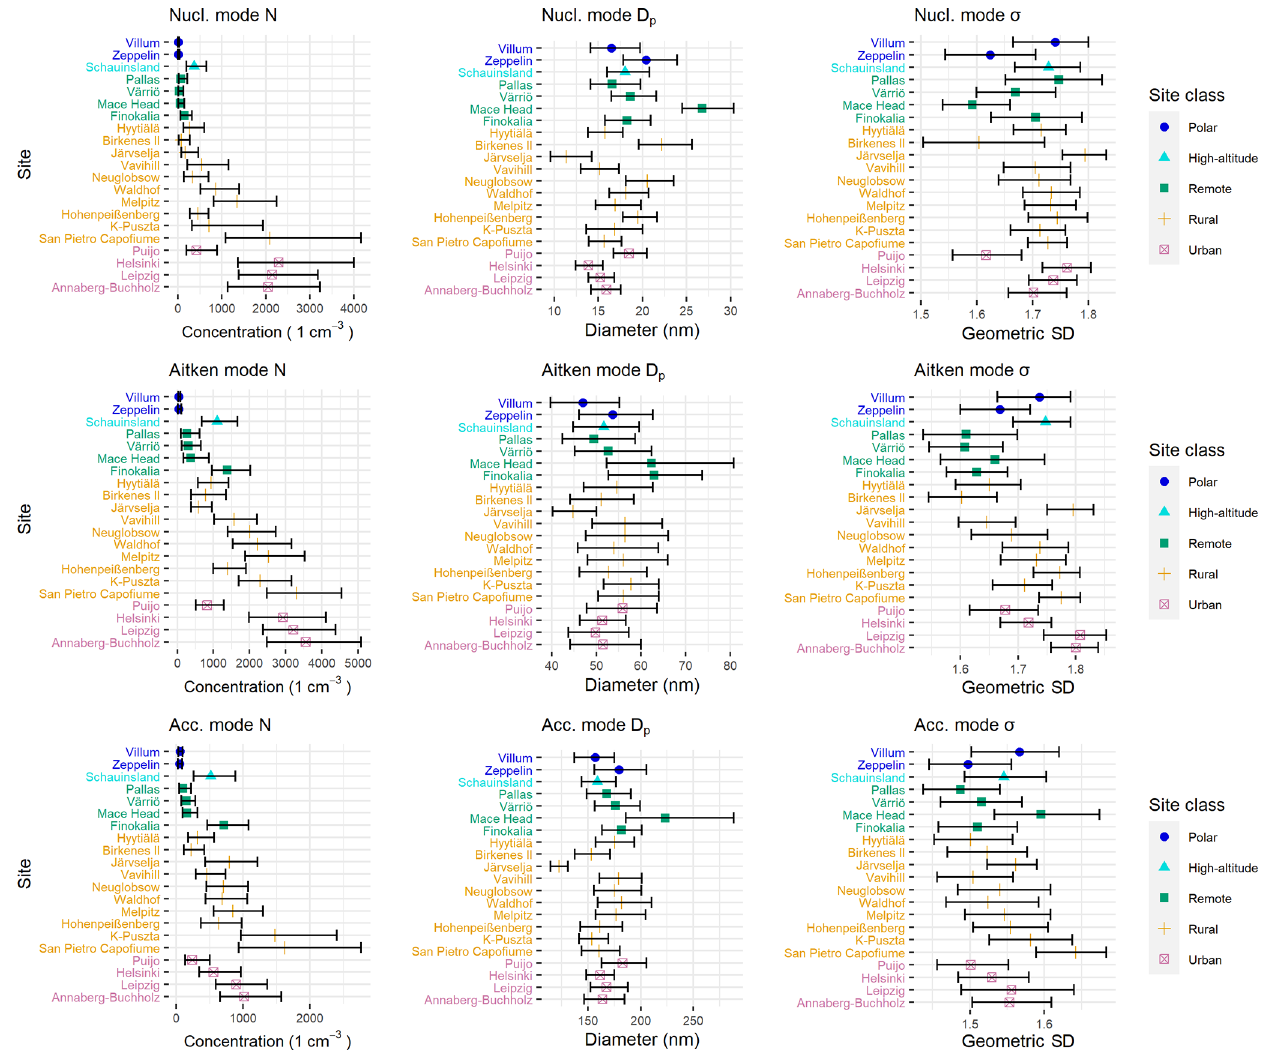
Figure 1. Summary of mode parameters (number concentration N , geometric mean diameter D p , and geometric standard deviation σ ) for the measurement sites. The median values are marked with dots and interquartile ranges (25% and 75%) with whiskers for different mode parameters in fitted